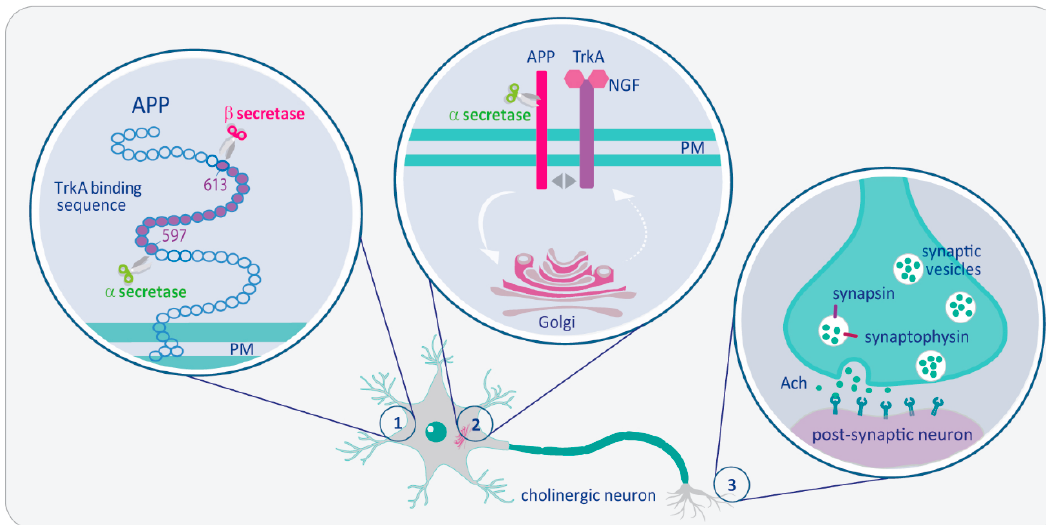
Figure 1. NGF/TrkA pathway modulates Amyloid Precursor Protein (APP) metabolism and synaptic functions in adult forebrain cholinergic neurons. (1) Studies reported in this review and in former studies indicate that the stretch of 16 amino acids (597–613) of the juxtamembrane region of APP-695 molecule (human APP numbering) contains also the binding sites for the NGF receptors TrkA and p75, as well as the cleavage sites for α - and β -secretase; (2) Such tight proximity might allow NGF-TrkA complex to stimulate α -secretase activity in the plasmamembrane (PM) and APP trafficking from the PM to the Golgi (arrow), and most probably back to PM (dashed arrow), also enriched of α -secretase. By recycling APP through neuronal compartments where β -secretase is poorly represented, NGF ensures the preferential anti-amyloidogenic cleavage of APP by the α -secretase; (3) At the synaptic compartment, NGF/TrkA pathway sustains the expression level of synaptic vesicle proteins, like synapsin and synaptophysin, and the consequent Ach release, thus subserving physiological synaptic functions in cholinergic neurons. (BFCN, basal forebrain cholinergic neurons; APP, Amyloid precursor protein; PM, plasmamembrane; Ach, acetylcholine). The illustration was realized by V.T., with the help of Isabella Triaca for graphic elaboration.